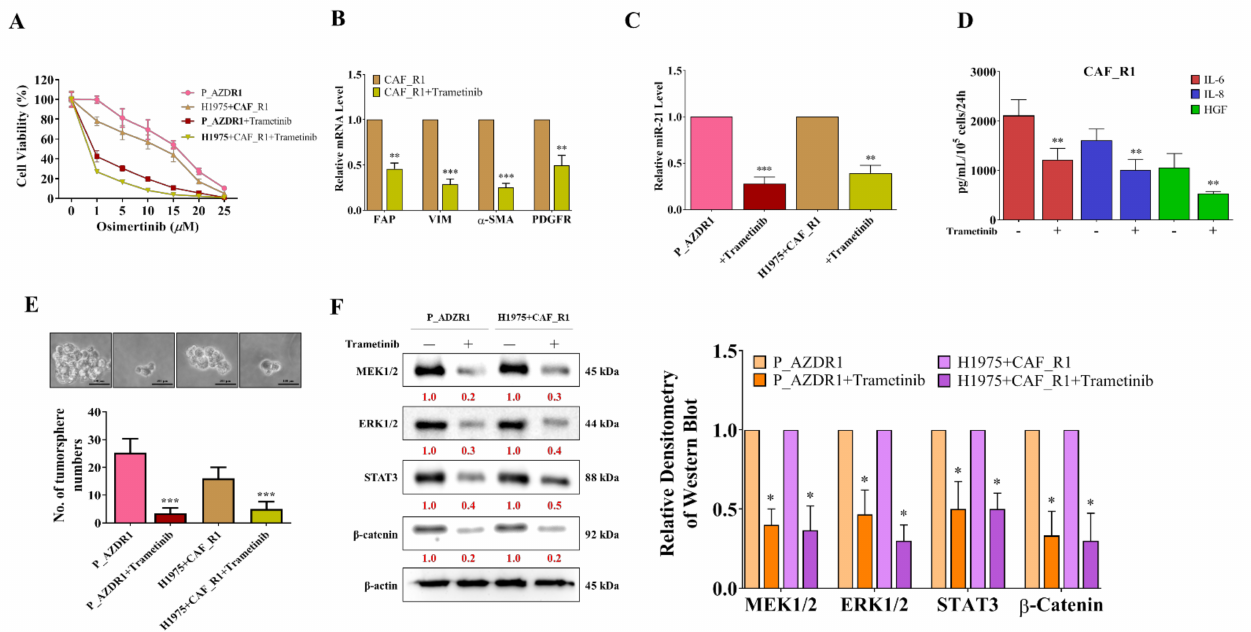
Figure 3. ( A ) Cell viability assay showed that sequential treatment of Trametinib (0.1 uM, 24 h) and Osimertinib (2 uM, 48 h) re-sensitized Osimertinib-resistant NSCLC cells (P_AZDR1 and H1975+CAF_R1). ( B ) Trametinib treatment resulted in significantly reduced CAF markers including FAP, VIM, α -SMA, and PDGFR in CAF_R1 cells. ( C ) qPCR analysis showed that Trametinib-treated P_AZDR1 and H1975+CAF_R1 cells contained a significantly lower level of miR-21 level. ( D ) ELISA assay analysis showed that CAF-associated cytokines, IL-6, IL-8, and HGF released were significantly reduced by the treatment of Trametinib in CAF_R1 cells. ( E ) Tumor sphere formation assay indicated that Trametinib treatment suppressed the self-renewal ability of both P_AZDR1 and H1975+CAF_R1 cells significantly and was supported by the western blot ( F ) where Trametinib-treated cells expressed a markedly reduced level of MEK1/2, ERK1/2, STAT3 and β -catenin and bar graph of multiple experiments. * p < 0.05, ** p < 0.01, *** p < 0.001. Scale bar: 100 µ